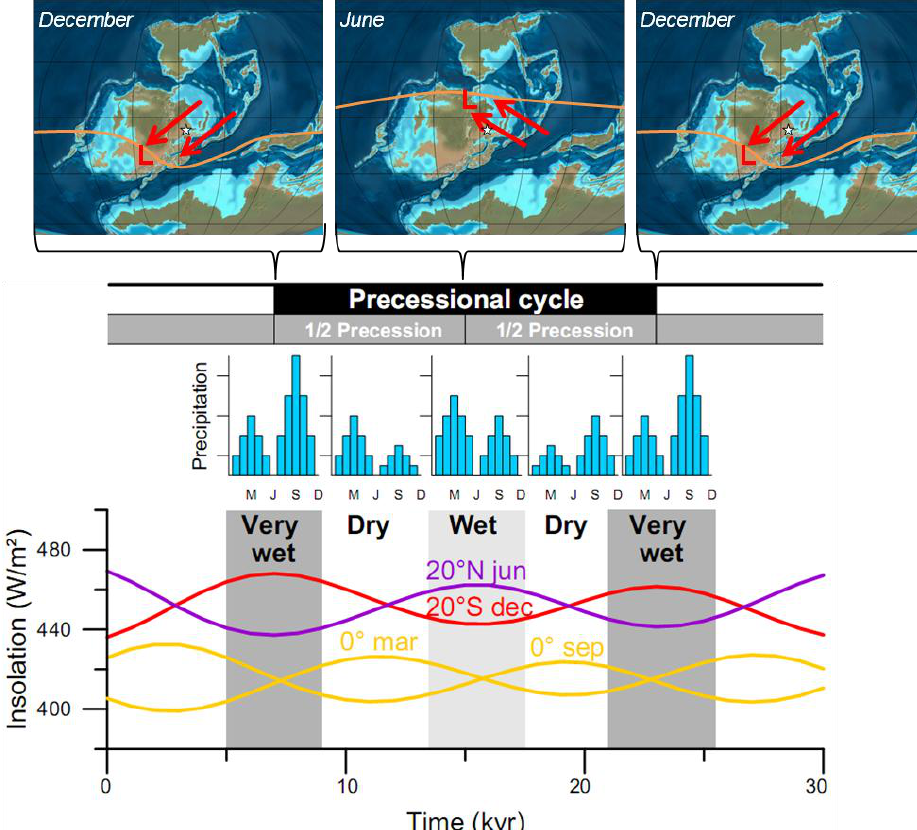
Fig. 10. Monsoon-like circulation in eastern Euramerica during the Mid-Devonian (Paleogeographic map from Ron Blakey, Northern Arizona University Geology). Intertropical Convergence Zone (ITCZ) in orange. Important trade winds are indicated by red arrows. L: Low pressure cell. A white stare indicates paleogeographic position of the study site. The schematic representations of the monthly precipitation pattern illustrate the dependence of precipitation intensity on precession. Insolation pattern is based on Berger et al. (1992) and insolation strength is estimated considering a 5% lower solar luminosity.